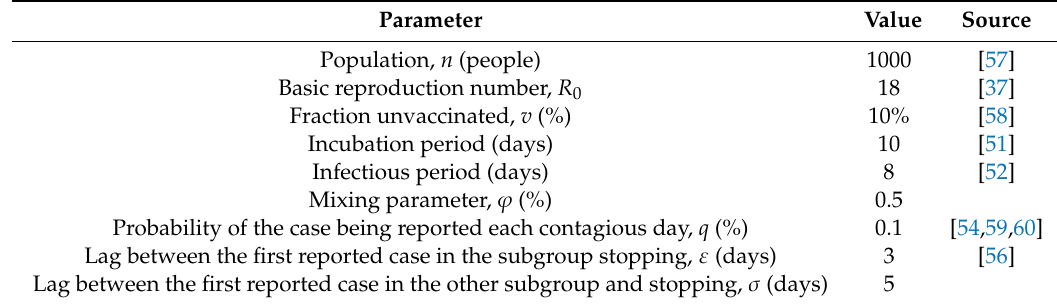
Table 2. Parameters.